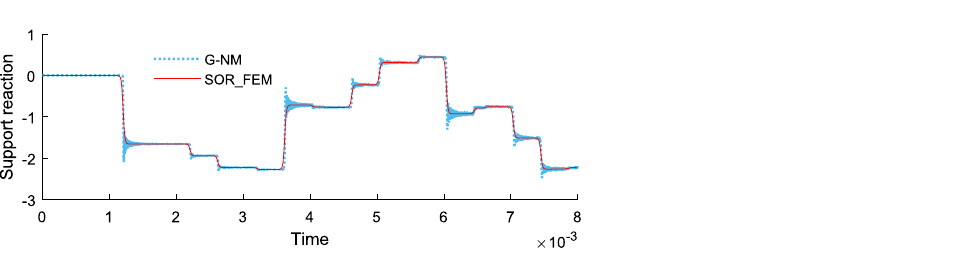
Figure 21. Time history of support